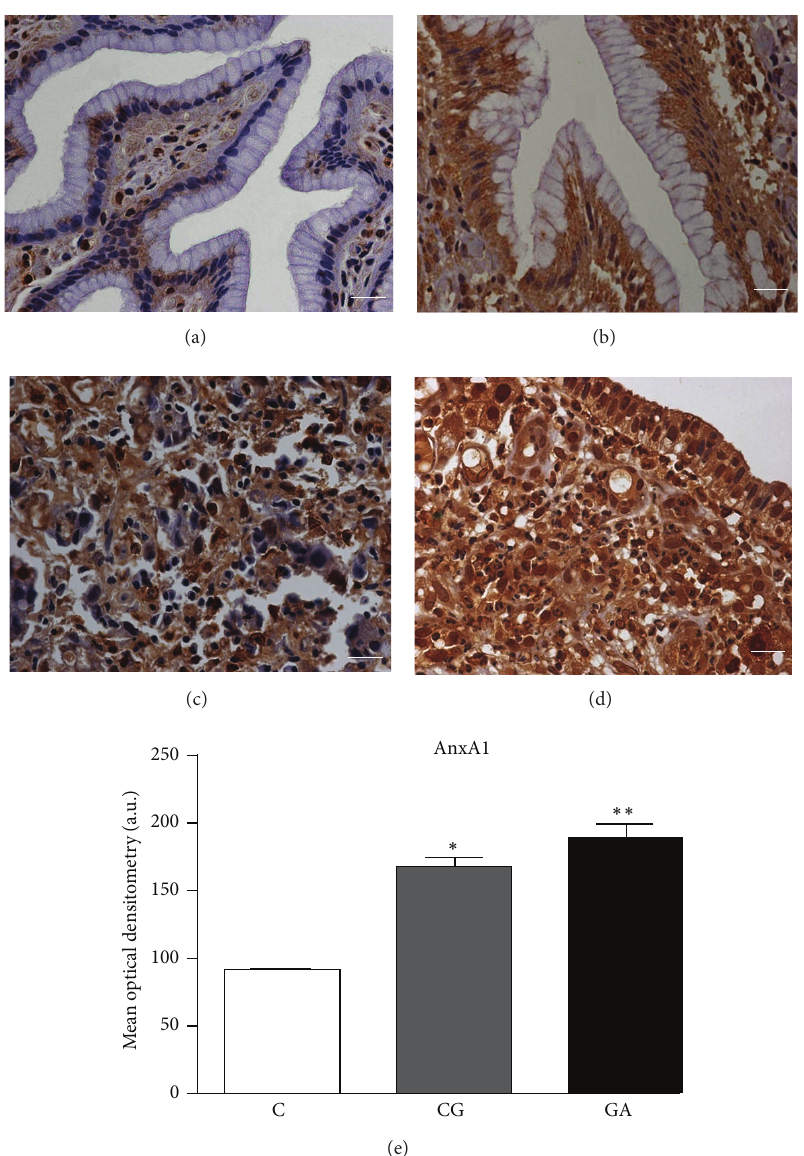
Figure 2: Endogenous annexin-A1 (ANXA1) expression in the gastric mucosa. Immunoreactivity of ANXA1 in sections of gastric mucosa tissue by rabbit polyclonal antibody ANXA1. (a) Histological analysis showing modest immunoreactivity in stroma and negative for epithelial cells in normal mucosa. Note the immunopositivity in basal portion of epithelial in (b) chronic gastritis and intense stromal-epithelial immunostaining in (c) diffuse-type adenocarcinoma and (d) intestinal-type adenocarcinoma. Hematoxylin counterstain. Bar: 20 𝜇 m. (e) Densitometry analyses on the gastric mucosa tissues immunostained for AnxA1 in normal mucosa (C), chronic gastritis (CG), and gastric adenocarcinoma (GA) groups. Comparison between the C group and the CG ( ∗ ) and GA ( ∗∗ ) groups was made by the ANOVA test, with 𝑃 < 0.01